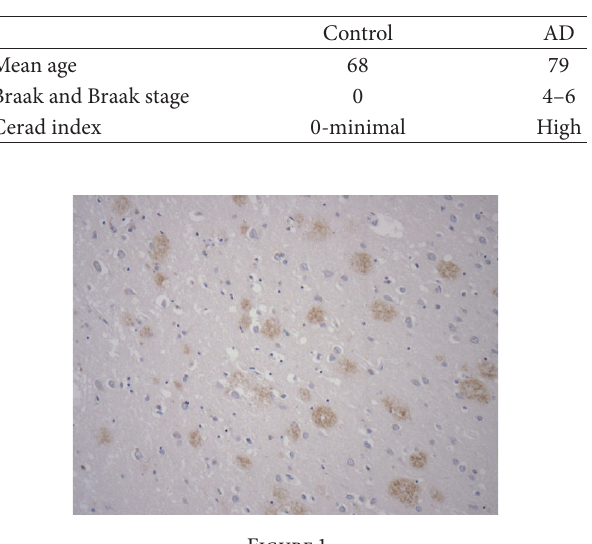
Table 1: Summary of cases-mean ages and ranges for diagnostic